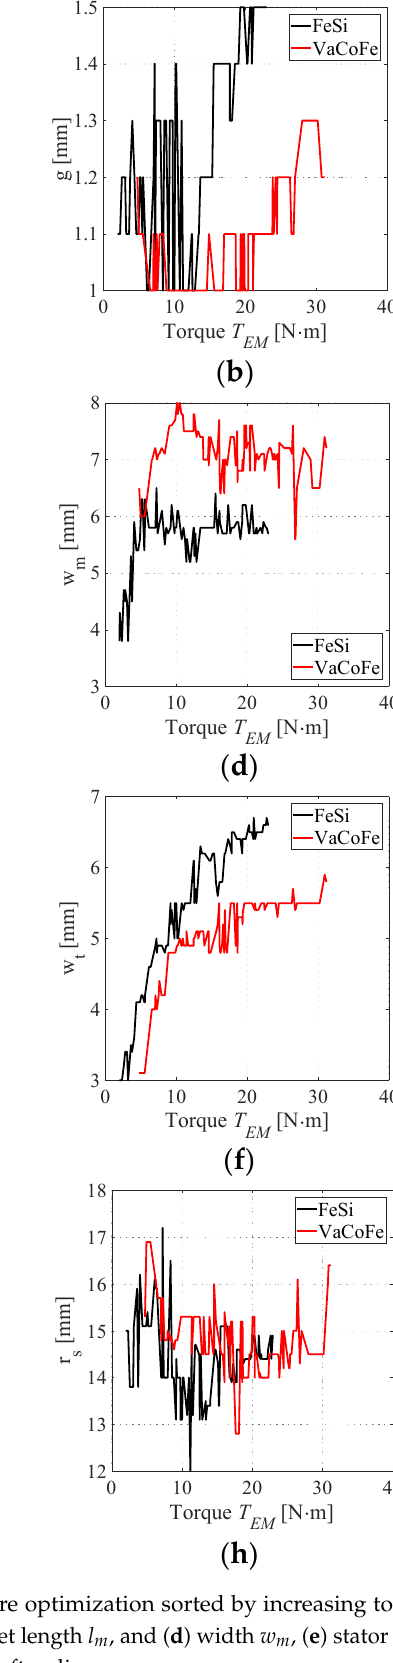
Figure 11. Decision variable for FeSi and VaCoFe core optimization sorted by increasing torque: ( a ) torque-producing current density J oq and ( b ) Pareto front with objective function efficiency and elec- tromagnetic torque values of the last generation. Geometries selected for further analysis are repre- sented.